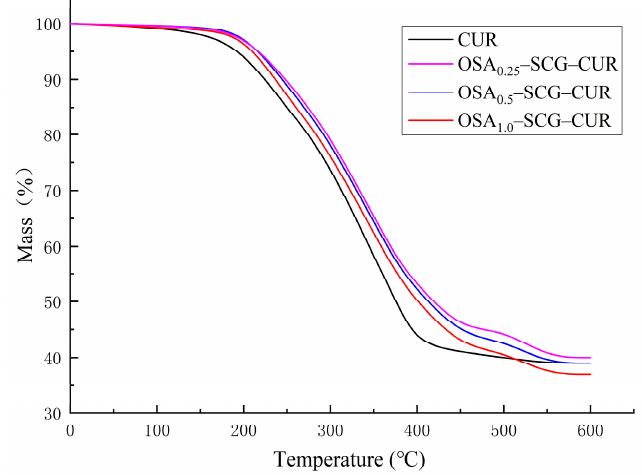
Figure 10. The TGA curves of curcumin and inclusion complexes.